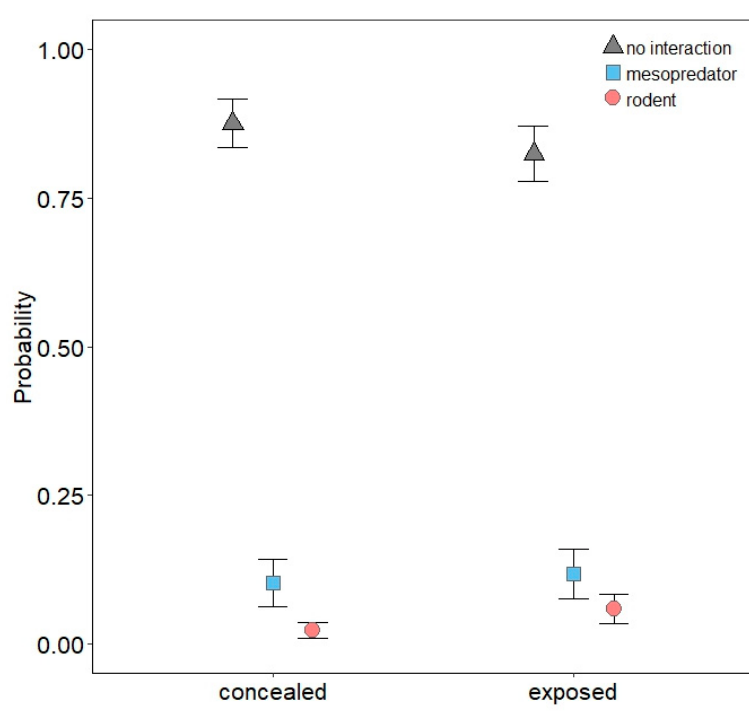
Figure 9. Probability with 85% confidence interval of mesopredators and rodents interacting with three-dimensional printed turtle models (or no interaction) depending on whether models were exposed or concealed.